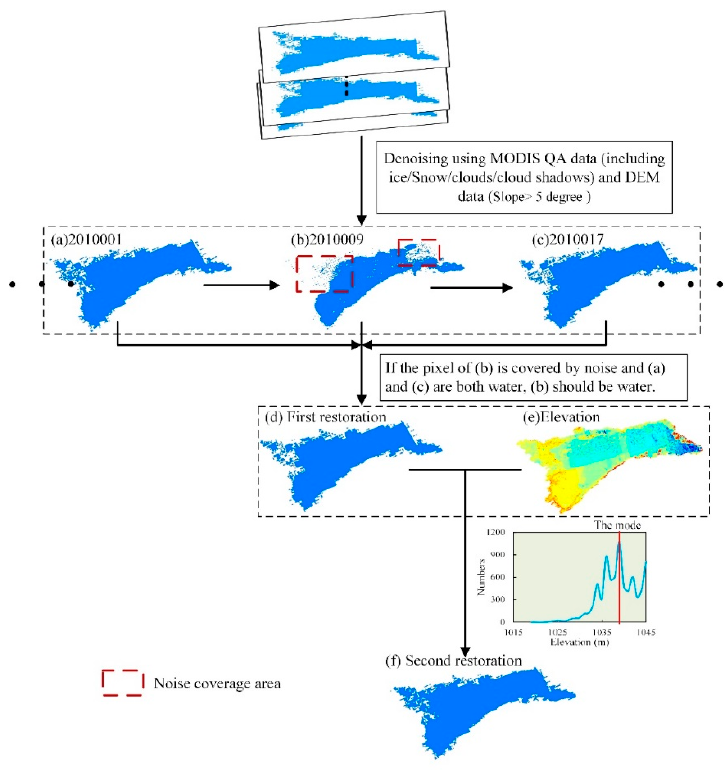
Figure 4. An illustrative example showing the water restoration after de-noise. ( a – c ) The denoised water results in Bosten Lake on 2,010,001th and 2,010,017th days, respectively; ( d , f ) the first and second water restoration results; and ( e ) the elevation data.